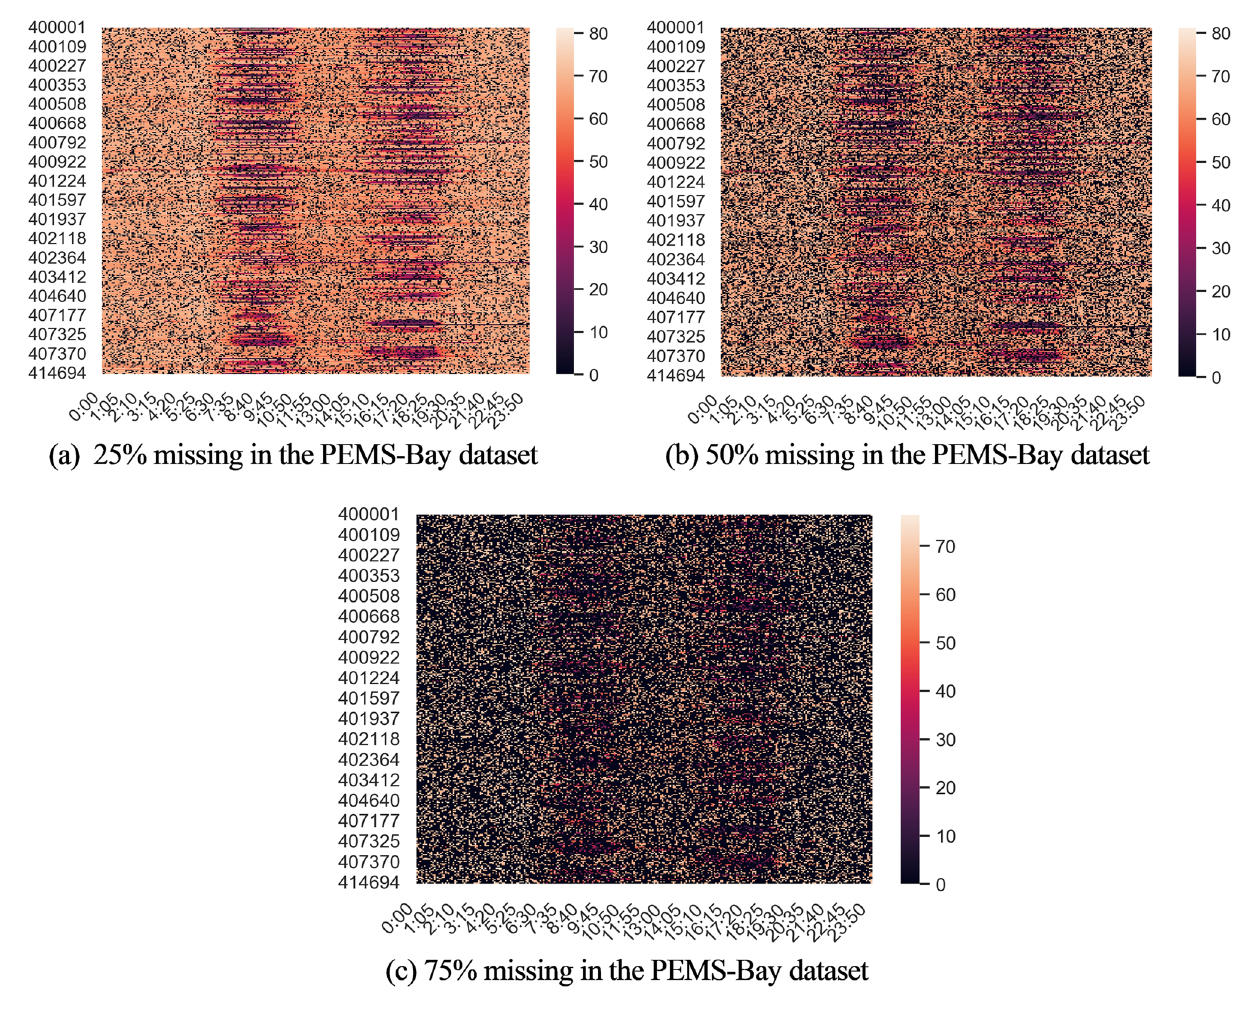
Figure 7. Heat map of the PEMS-Bay dataset at different deletion rates.